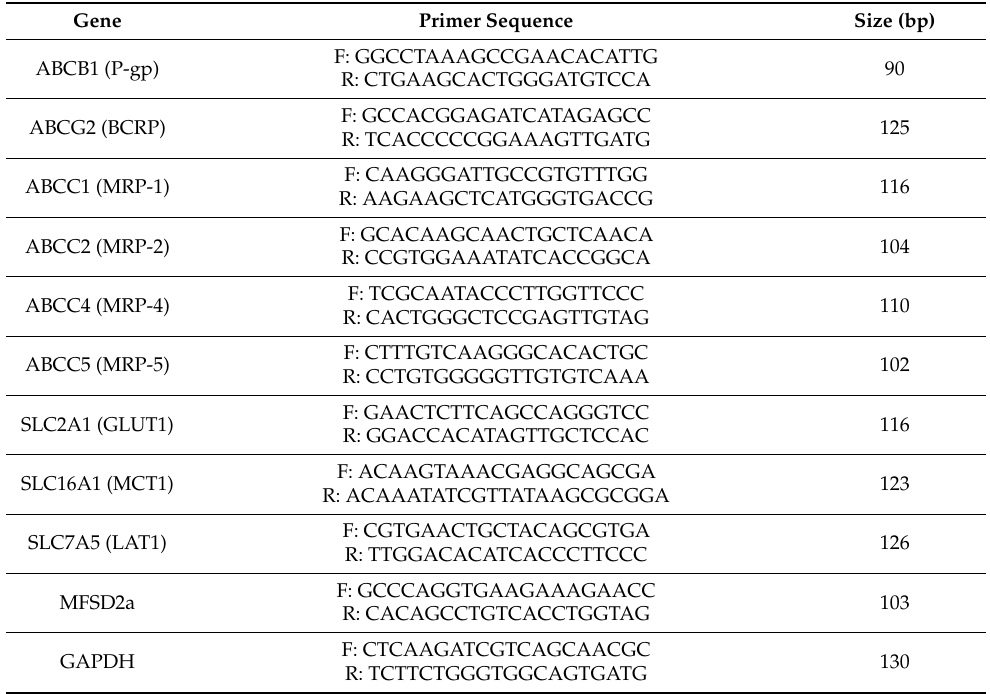
Table 1. Primers used for PCR